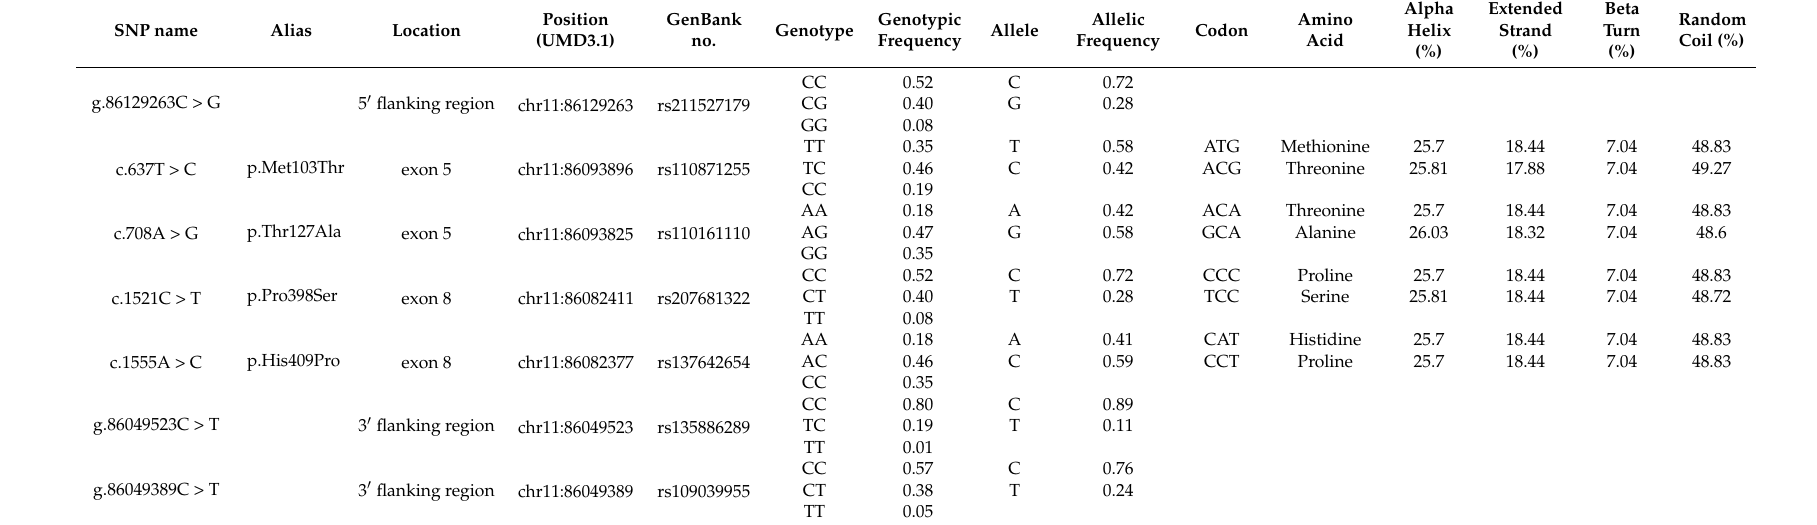
Table 1. Details of single nucleotide polymorphisms (SNPs) identified in LPIN1